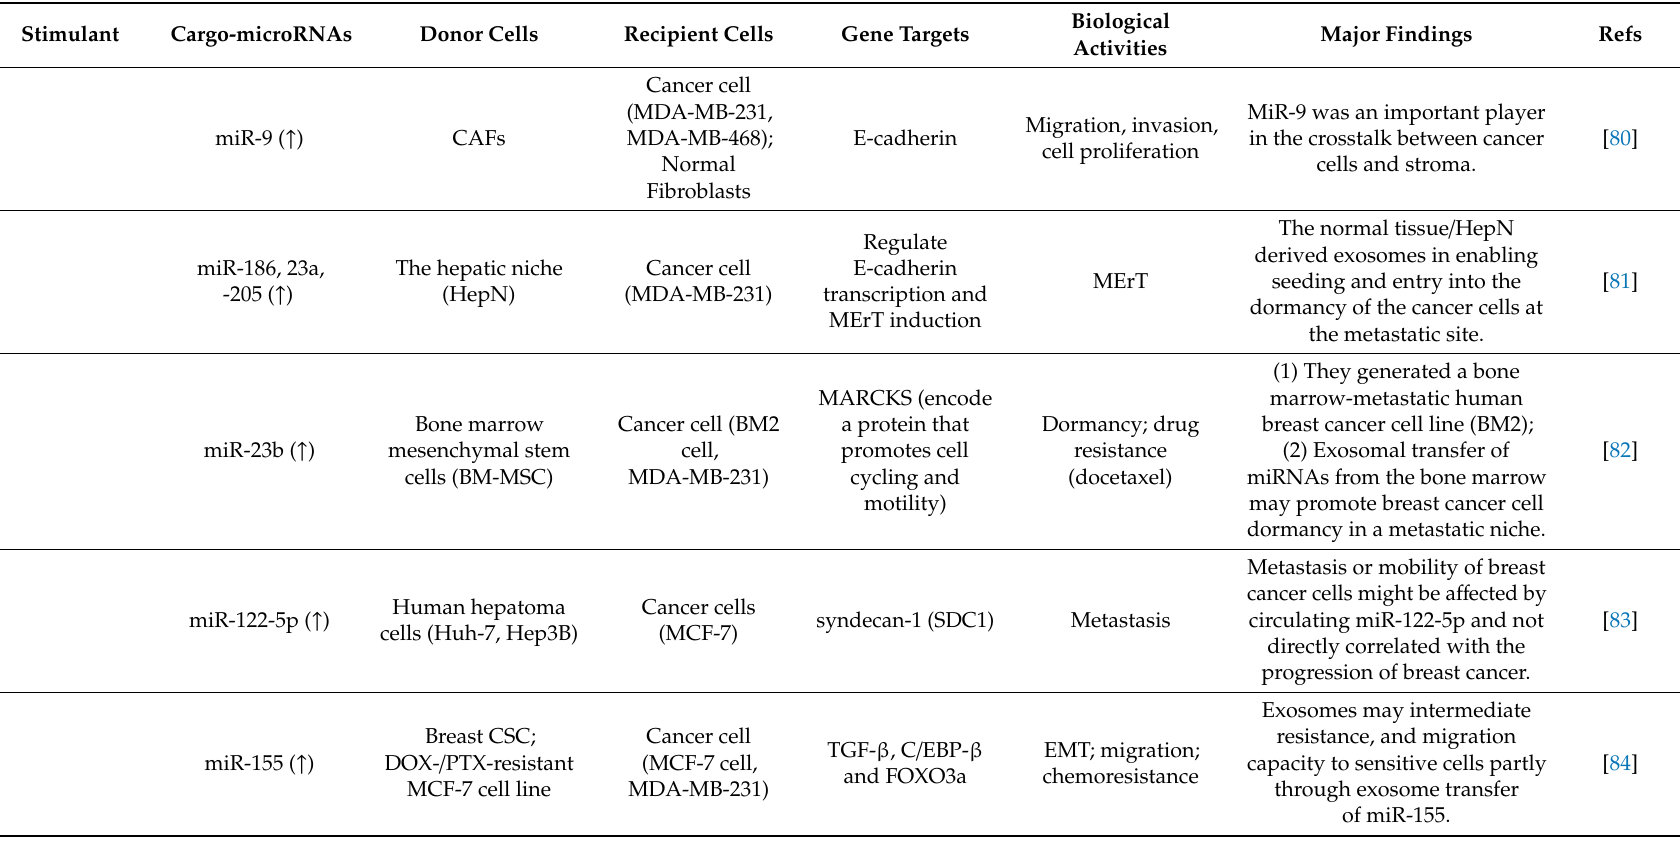
Table 3. Evidence supporting a role for exosomal microRNAs in cancer cell-cell communication (from stromal cells).